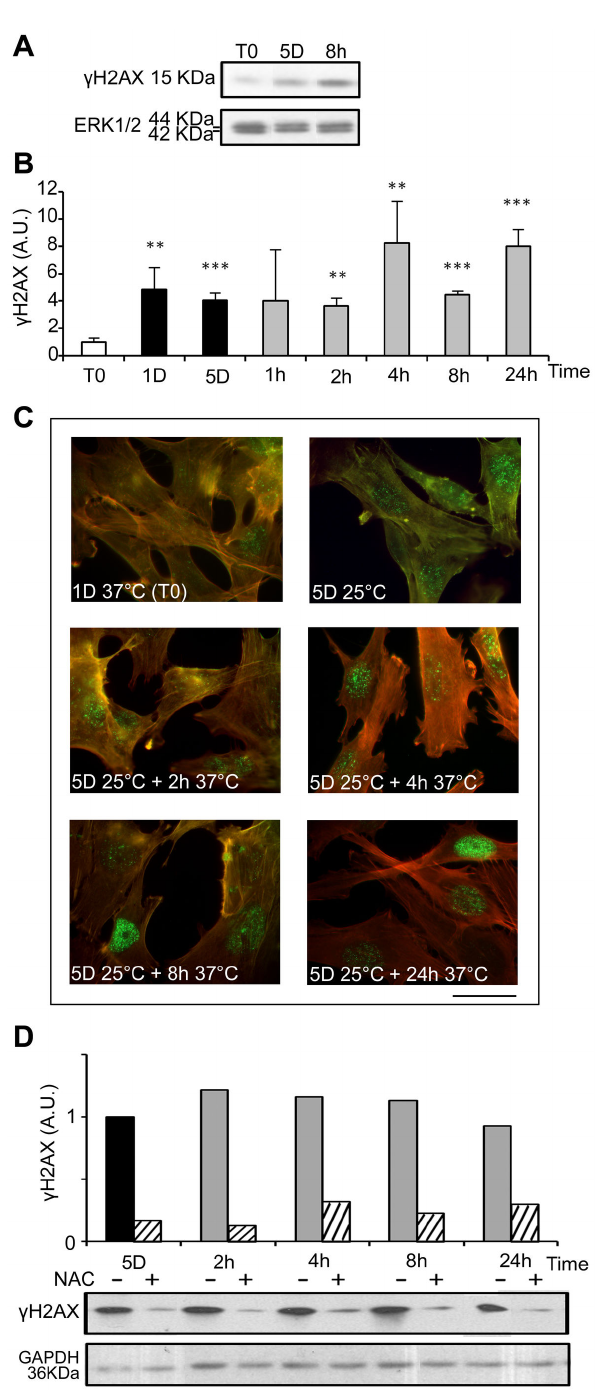
Figure 7. Cold shock and rewarming induce H2AX phosphorylation through ROS production. The levels of phosphorylated H2AX (γH2AX) were analyzed in WI26 cells cultured at 25°C for 1 and 5 days and then warmed-up at 37°C for 1 to 24h. (A) Representative western blots. (B) γH2AX was quantified by western blotting. Data are expressed in arbitrary units after normalization by ERK1/2, taking T0 as 1. (C) γH2AX in WI26 cells in normal conditions (1D37°C) and during cold shock for 5 days and rewarming for 2 to 24h was evidenced by immunostaining. Actin stress fibers are stained in red and γH2AX in green. Bar: 100µm. (D) γH2AX was measured by western blot in WI26 cells cultured at 25°C for 5 days and then warmed-up at 37°C for 2 to 24h in absence (-) and in presence (+) of NAC 15mM added at T0. After normalization by GAPDH, results are expressed in arbitrary units taking 5D as 1. doi: 10.1371/journal.pone.0069687.g007 PLOS ONE |